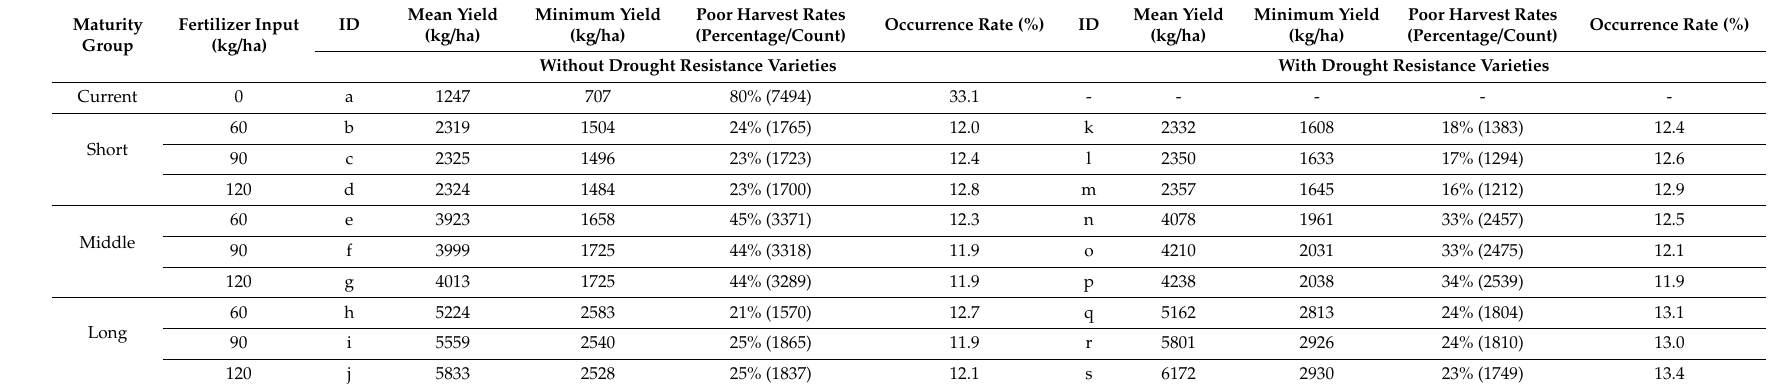
Table 2. Mean, minimum maize yields, poor harvest areas and occurrence rate across